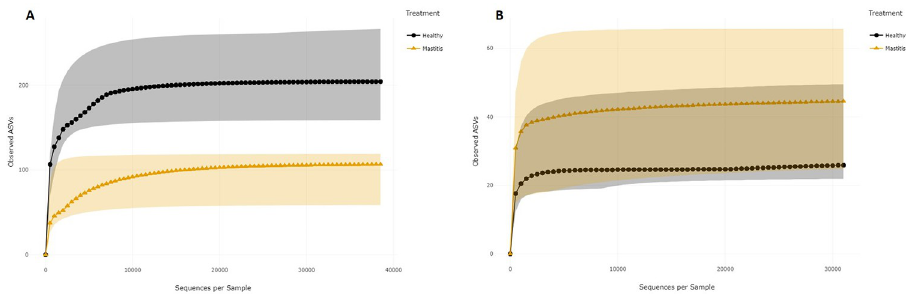
Fig 11. Rarefaction curves (median values) with interquartile ranges according to sample groups for the 16S rRNA (A) and for the ITS (B).